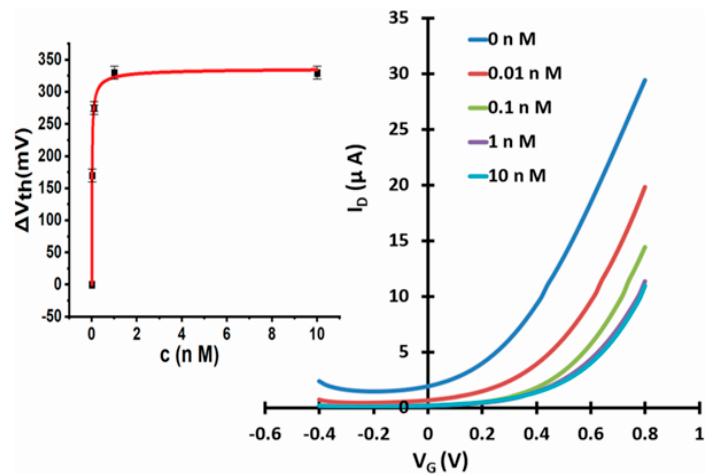
Figure 9. WGTFT fluoride sensors under simultaneous analyte and interferant. Response characteristics